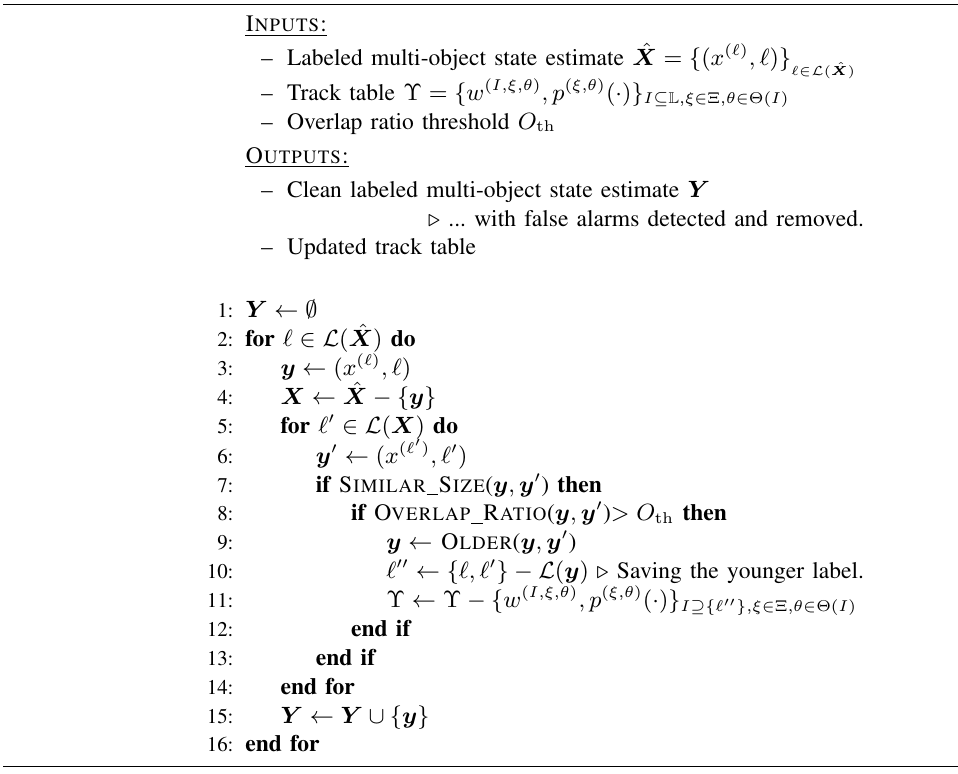
Algorithm 1 Pseudocode for the proposed false alarm removal and detection